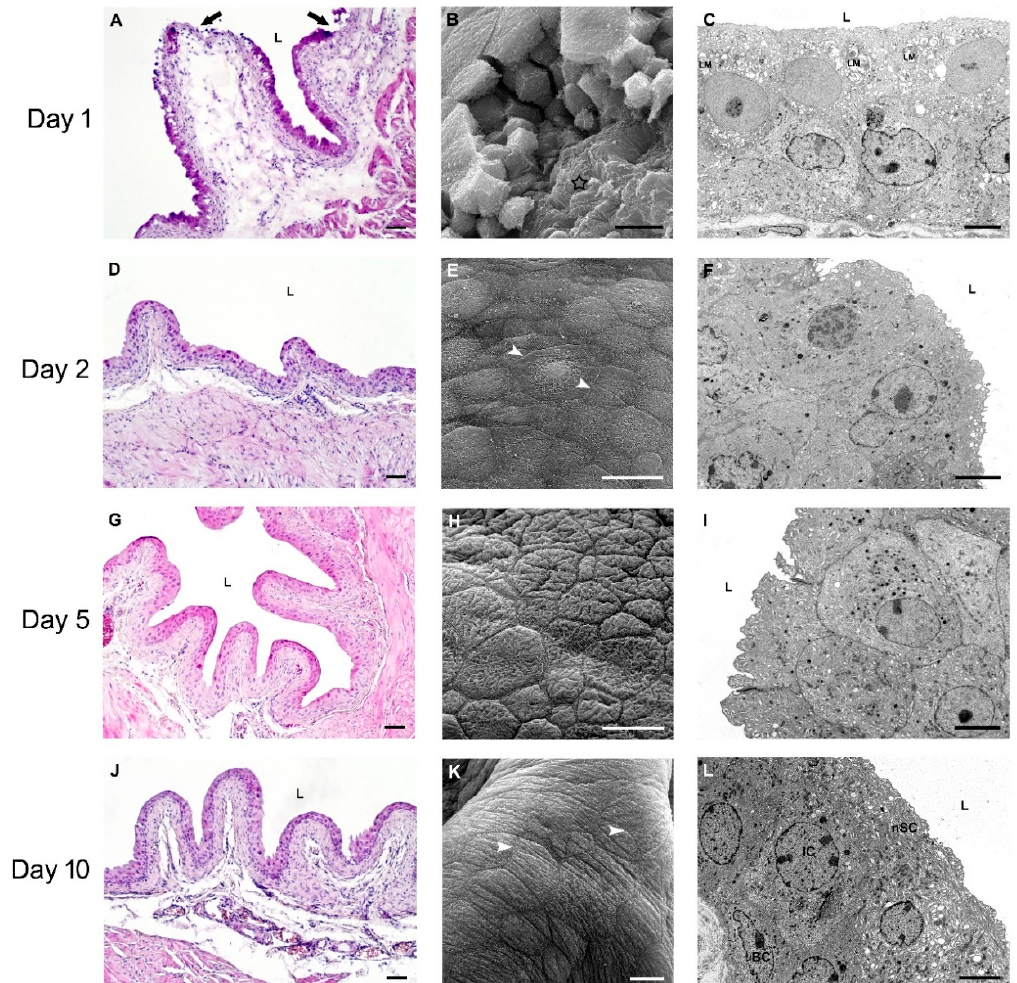
Figure 4. Representative micrographs of the urothelium during regeneration in old mice. On day 1 after chitosan treatment ( A – C ), the urothelium is mostly two-layered ( A , C ) with some areas of completely denuded urothelium, where the basal lamina is exposed (arrow in A , star frame in B ). New superficial cells have numerous lamellar bodies (LM) in the cytoplasm ( C ). On day 2 after chitosan treatment ( D – F ), the urothelium is predominantly three-layered ( D , F ) with some hyperplastic regions and well-developed tight junctions (arrowheads) between superficial cells ( E ). The urothelial luminal surface is composed of a heterogeneous population of superficial cells, which di ff er in size and structure of the apical surface, but cells with ropy ridges are in the majority ( E ). On day 5 after chitosan treatment ( G – I ), the urothelium is mostly three-layered ( G , I ). Superficial cells are of various sizes and di ff erentiation stages, but cells with a typically scalloped apical plasma membrane are dominant ( H ). On day 10 after chitosan treatment ( J – L ), the urothelium is continually tree-layered ( J , L ) with a homogeneous population of large superficial cells having a typically scalloped apical plasma membrane, well-developed tight junctions (arrowheads in K ), and numerous fusiform vesicles in the cytoplasm ( L ). ( A , D , G , J ) Hematoxylin and eosin (H&E) staining; ( B , E , H , K ) Scanning electron microscopy; ( C , F , I , L ) Transmission electron microscopy. L-lumen of the urinary bladder, BC-basal cells, IC-intermediate cells, nSC-new superficial cells. Scale bars: 100 µ m ( A , D , G , J ); 10 µ m ( B ); 20 µ m ( E , H , K ); 6 µ m ( C , F , I , L ).